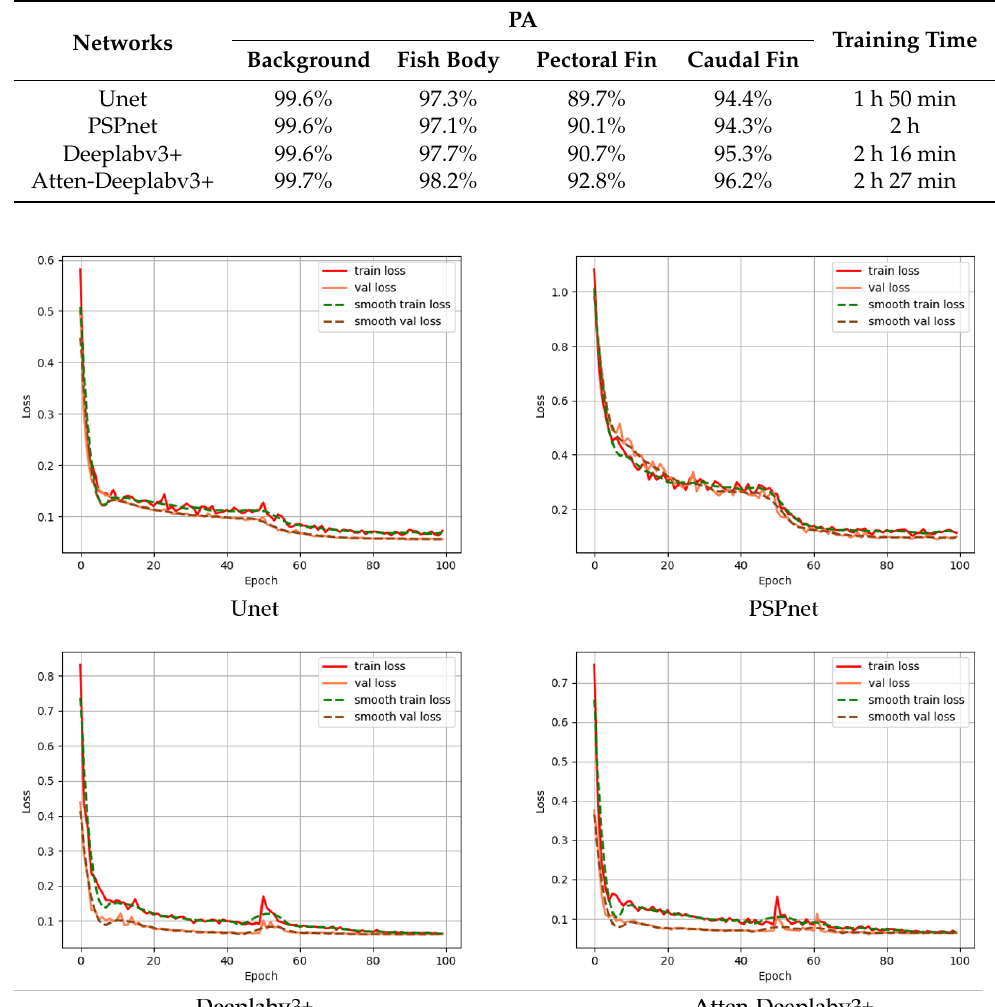
Figure 4. The loss curves for semantic segmentation networks. Table 1. The IoU results for semantic segmentation networks.